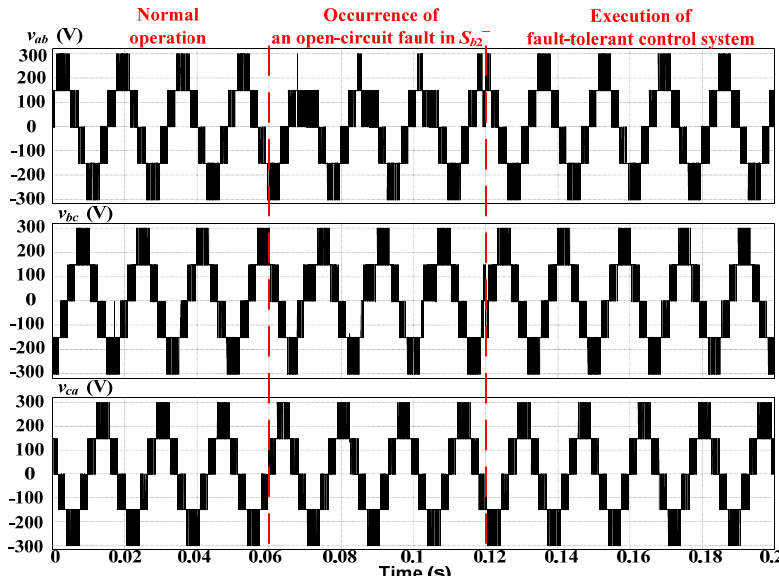
Figure 14. The output voltage of S b 2 − after the occurrence of an open-circuit fault and the activation of fault-tolerant control.